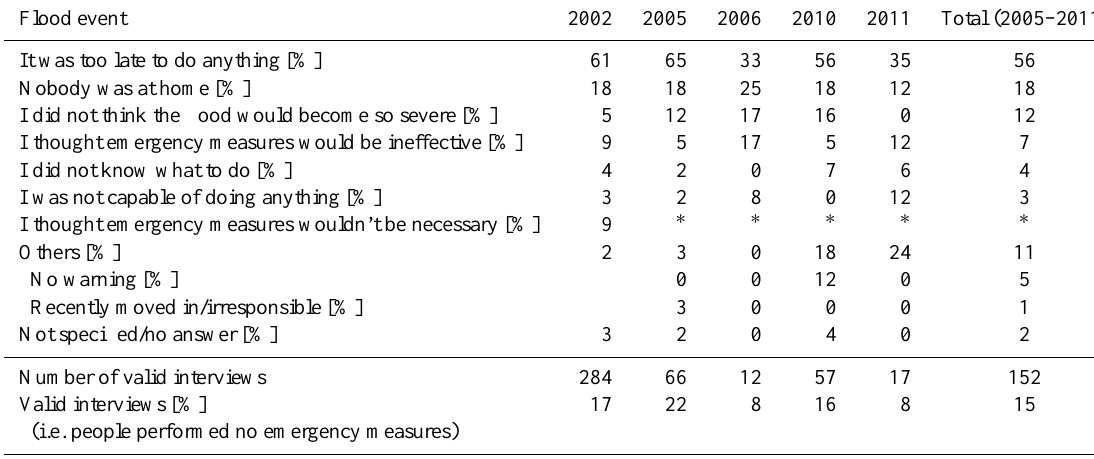
Table 8. Reasons why people did not perform emergency measures (multiple answers possible). Flood